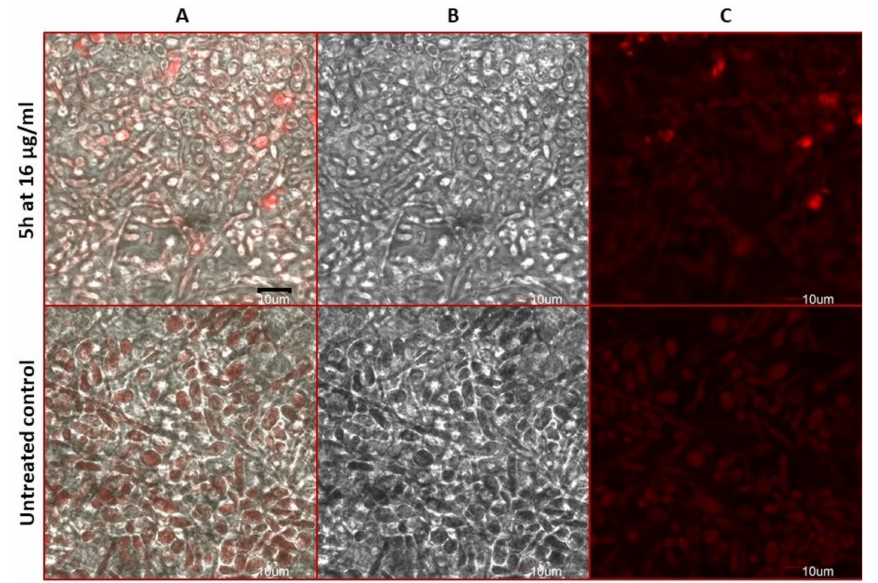
Figure 9. The C. albicans SPZ 176 sessile cell-death assessment. Legend: Confocal laser scanning microscope (CLSM) analyses of acridine orange (AO)- and ethidium bromide (EB)-stained biofilm cells. ( A ) phase contrast and fluorescence merged; ( B ) phase contrast and ( C ) fluorescence images. ( A – C ) Upper raw shows necrotic cells treated with 5h at 16 µ g/mL. Lower raw displays viable untreated control cells without uptaking